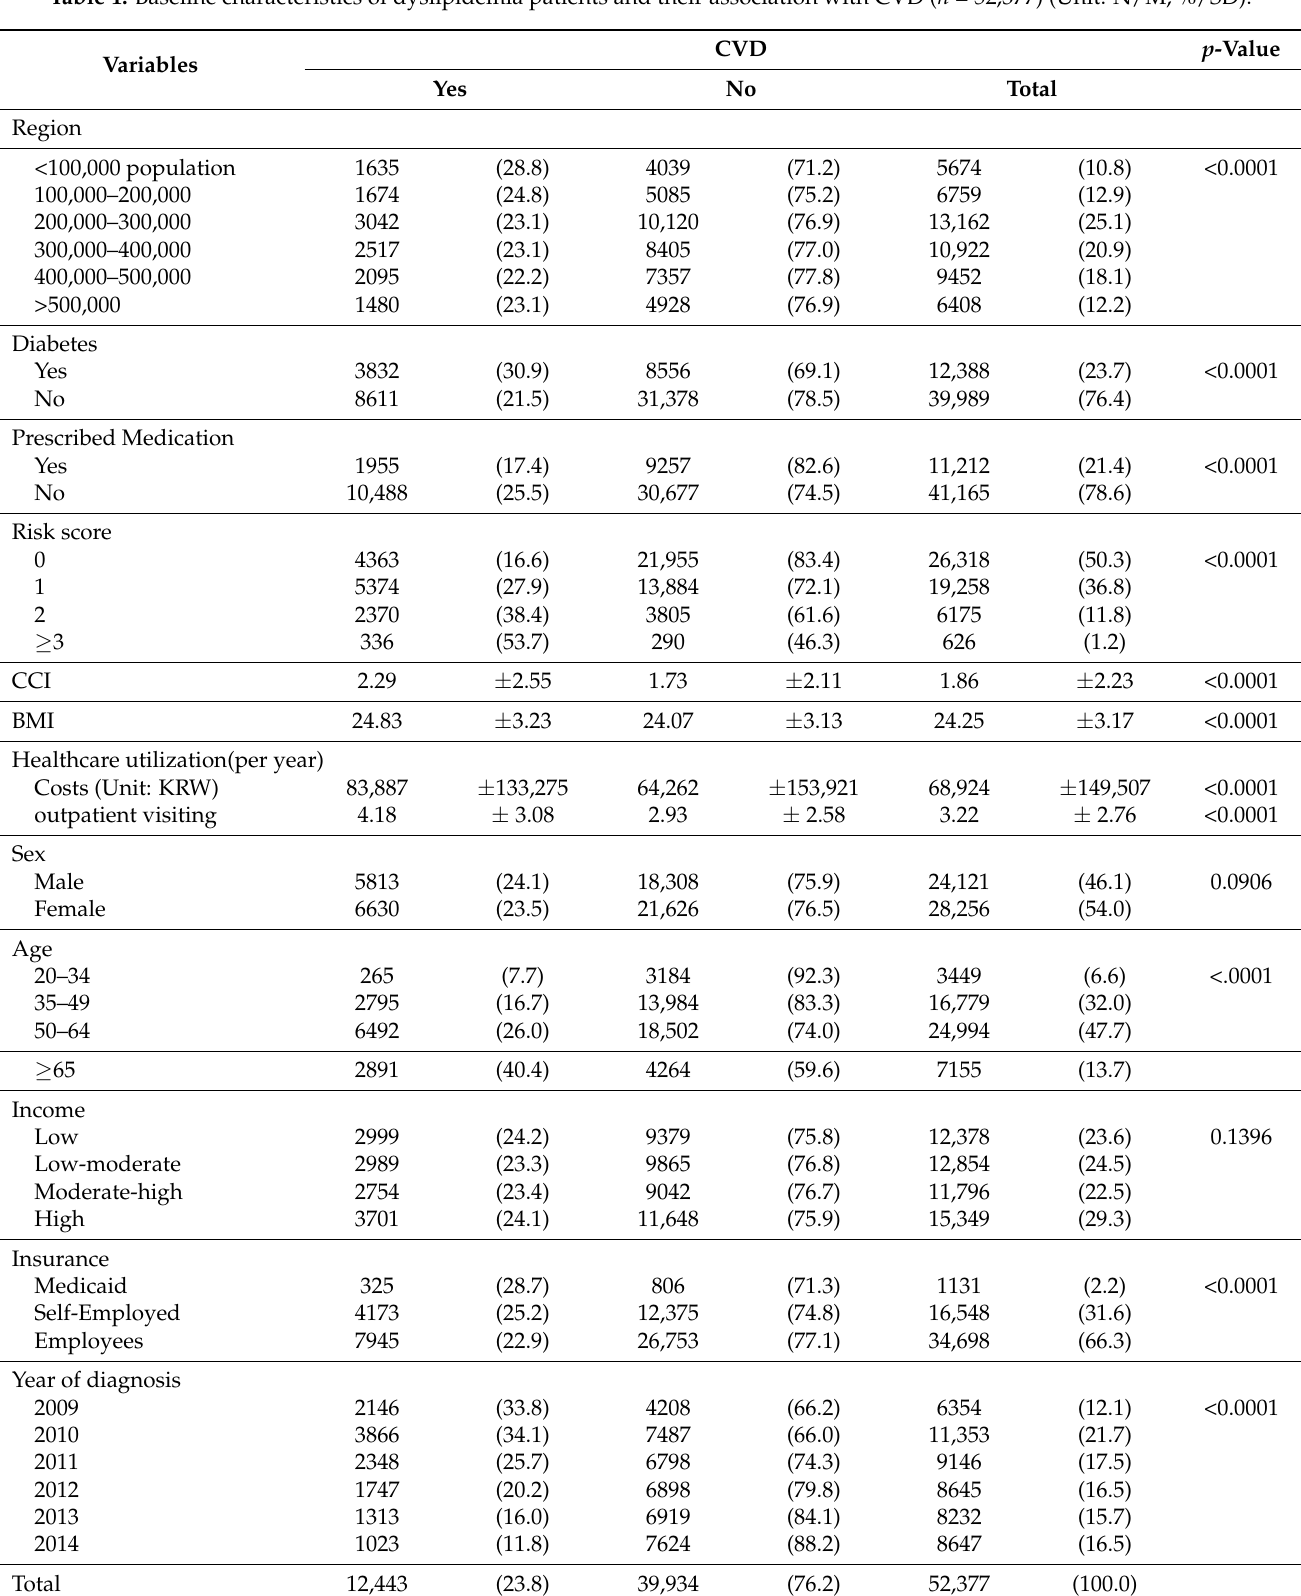
Table 1. Baseline characteristics of dyslipidemia patients and their association with CVD ( n = 52,377) (Unit: N/M,